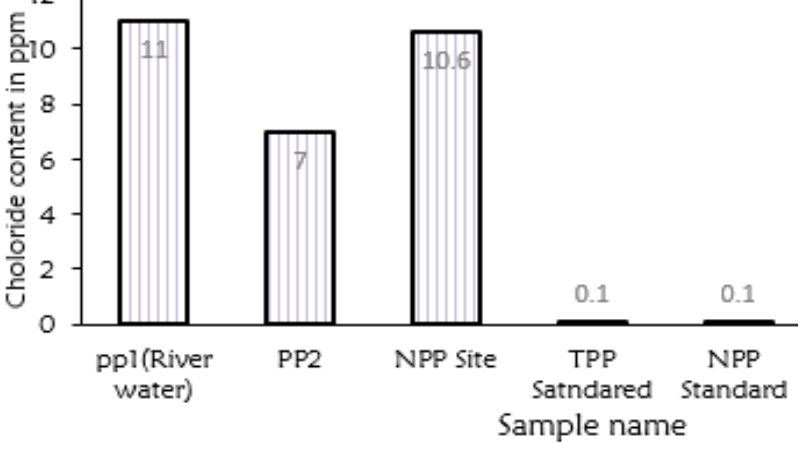
Figure 5: Analysis of Chloride content between raw water and DM